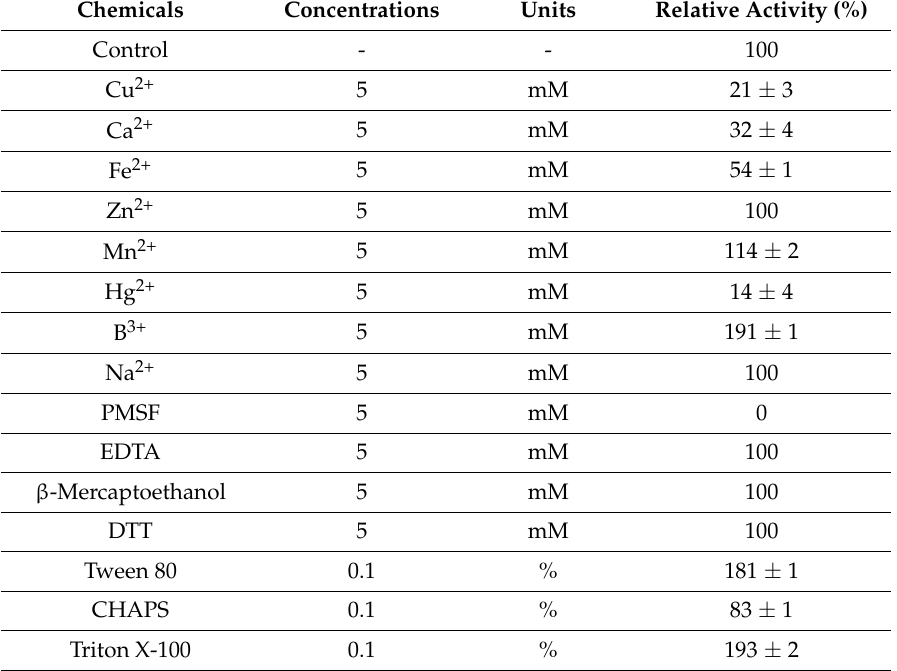
Table 8. Effect of metal ions (5 mM), detergents (0.1%) and enzyme inhibitors (5 mM) on protease activity of the endophytic fungus Penicillium bilaiae